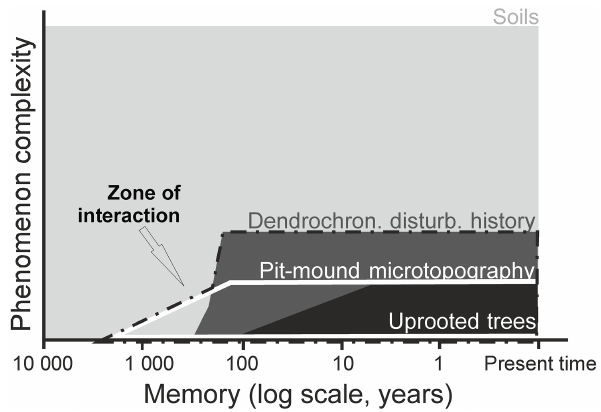
Figure 3. Memory length and complexity of individual data sets. The dash–dotted line represents the zone of our main interest, where we hypothetically expect significant relations between data